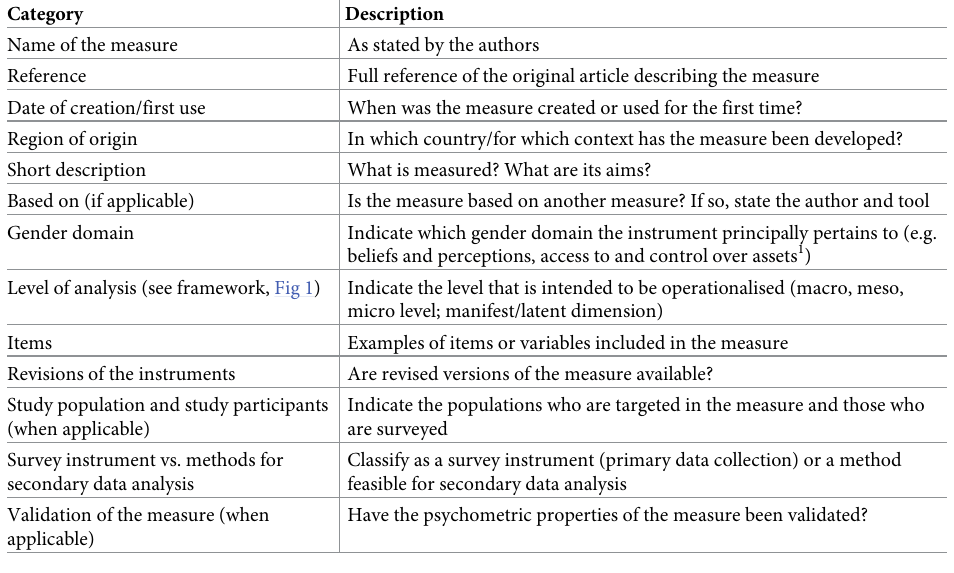
Table 1. Data charting